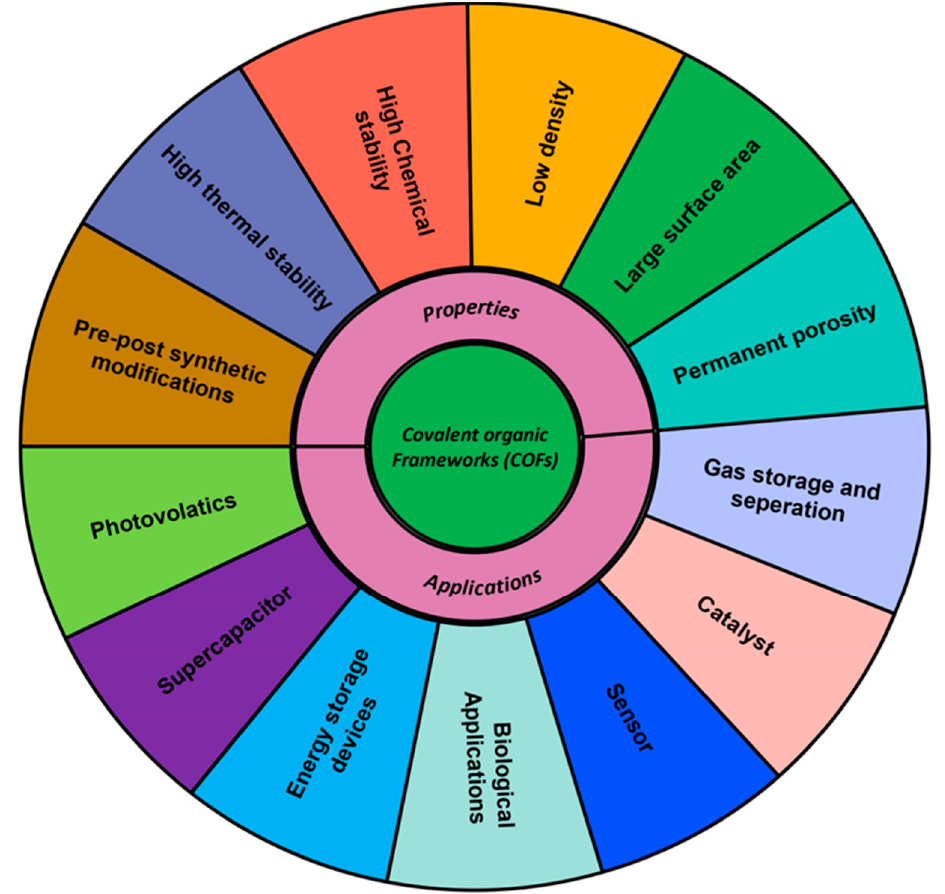
Figure 1. Properties and applications of